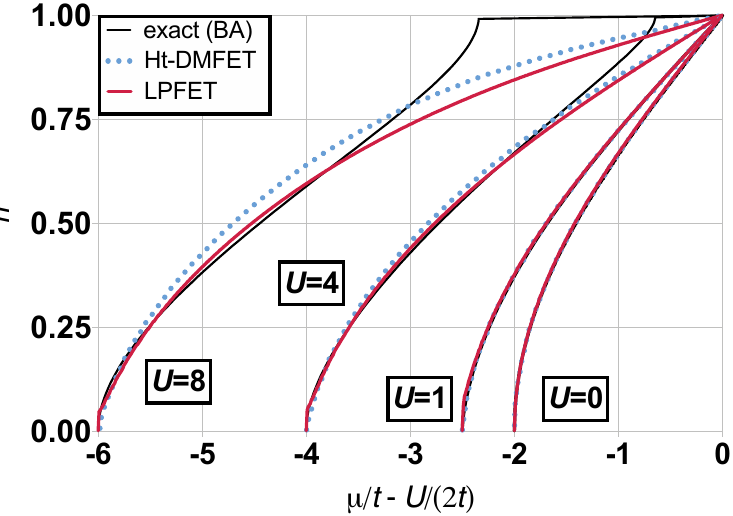
Figure 5. Converged LPFET densities (red solid lines) plotted as functions of the chemical potential µ in various correlation regimes. Comparison is made with the exact BA (black solid lines) and Ht- DMFET (blue dotted lines) results. In the latter case, the chemical potential is evaluated via the numer- ical differentiation of the density-functional Ht-DMFET per-site energy (see Equations (62) and (76)). The non-interacting ( U = 0) chemical-potential-density map (see Equation (60)) is shown for analysis